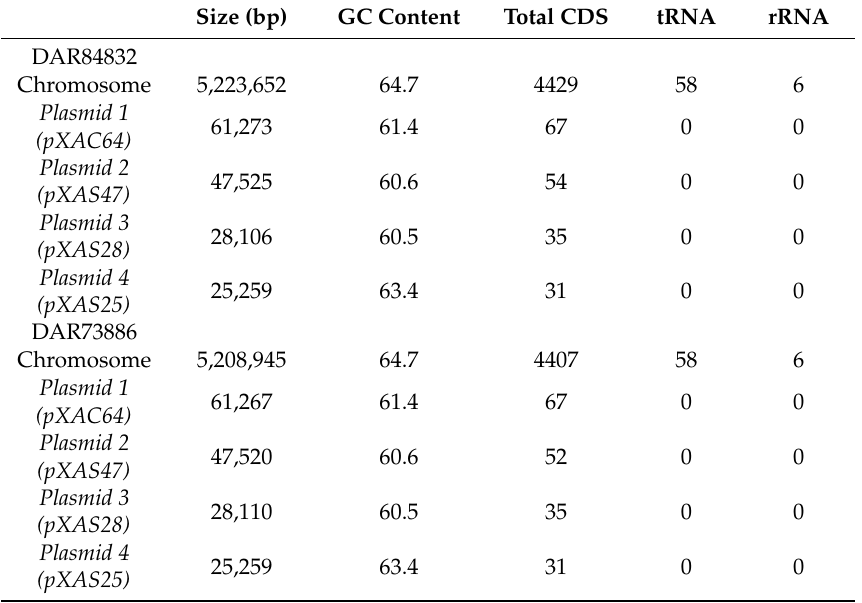
Table 2. General features of chromosomal and plasmid DNA in assembled X. citri pv. citri A* . Size